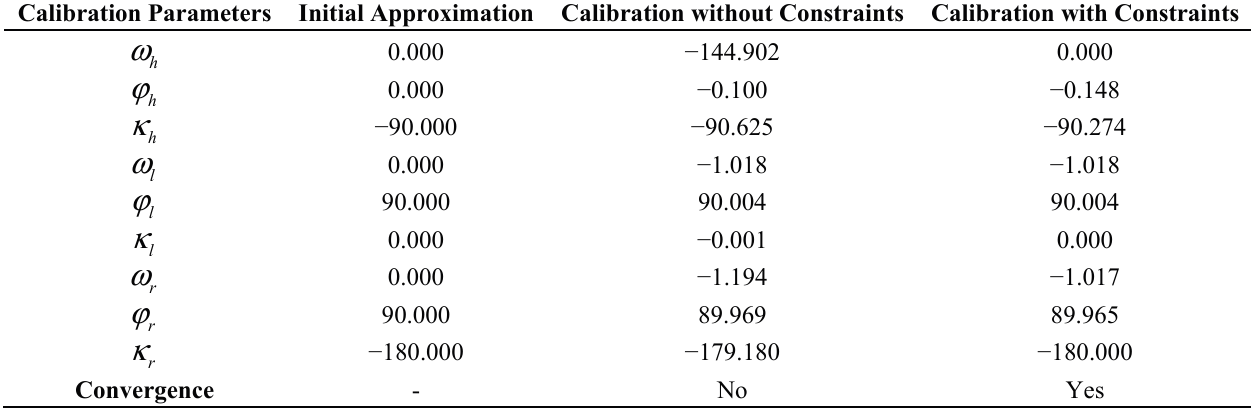
Figure 15. Correlation matrix of the calibrated parameters ( a ) without and ( b ) with the constraints. Table 4. Calibration parameters (unit: